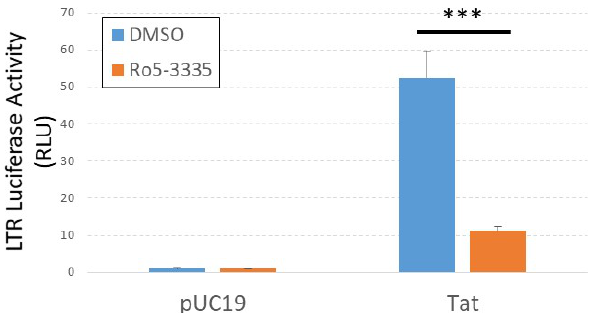
Figure 3. Ro5-3335 inhibits Tat transactivation of the integrated LTR. TZMbl cells were transfected with pUC19 control plasmid or pCMV-Tat plasmid, treated with 50 µ M of Ro5-3335 at 24 h post-transfection, and measured for luciferase expression 48 h post-transfection. *** P ≤